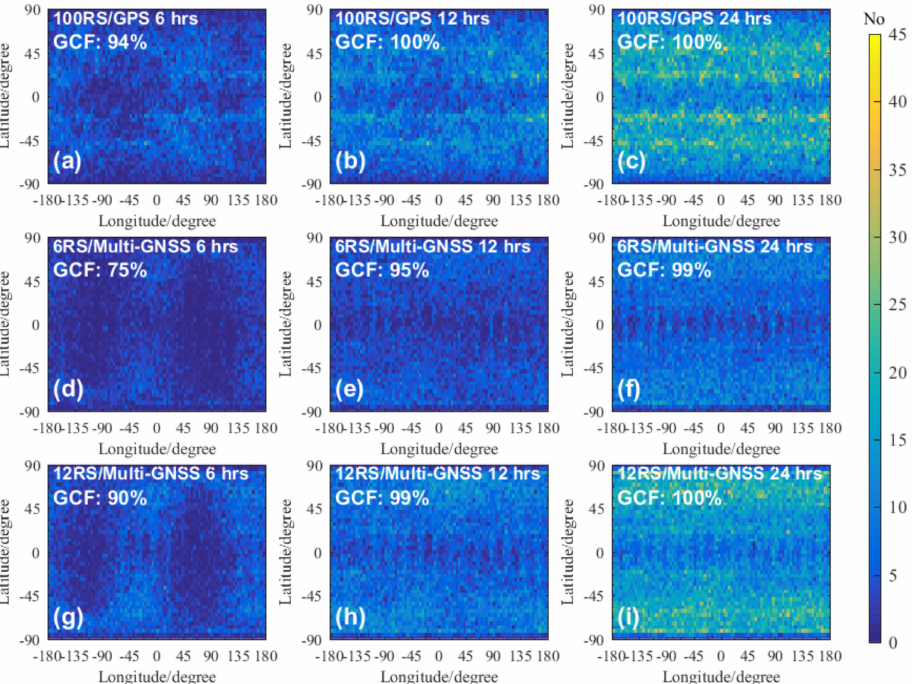
Figure 5. The global coverage of GNSS RO events for 100RS/GPS, 6RS/multi − GNSS and 12RS/multi − GNSS RO systems, illustrating the number of RO event revisits using a 4 ◦ × 4 ◦ latitude and longitude grid coordinate.